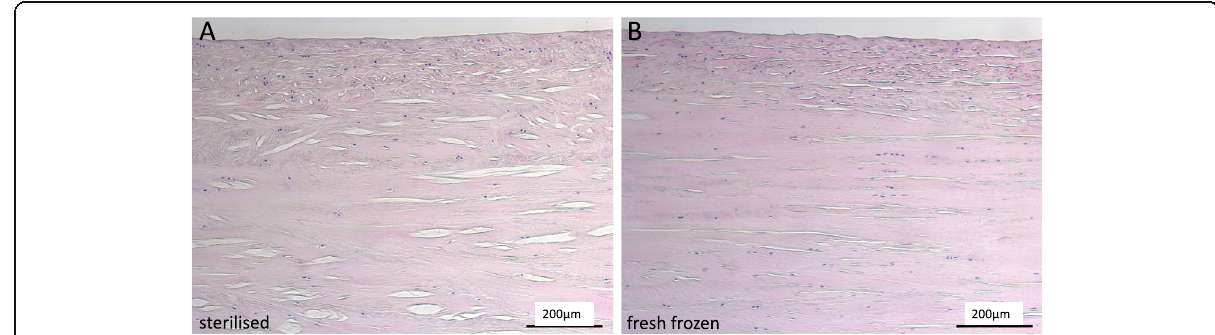
Fig. 5 Representative longitudinal sections of PAA treated ( a ) and fresh-frozen ( b ) menisci are shown after H&E staining. The scale bar depicts 200 μ m and n = 4. Evenly distributed lacunae were present in both types of menisci. Lacunae were wider in PAA treated